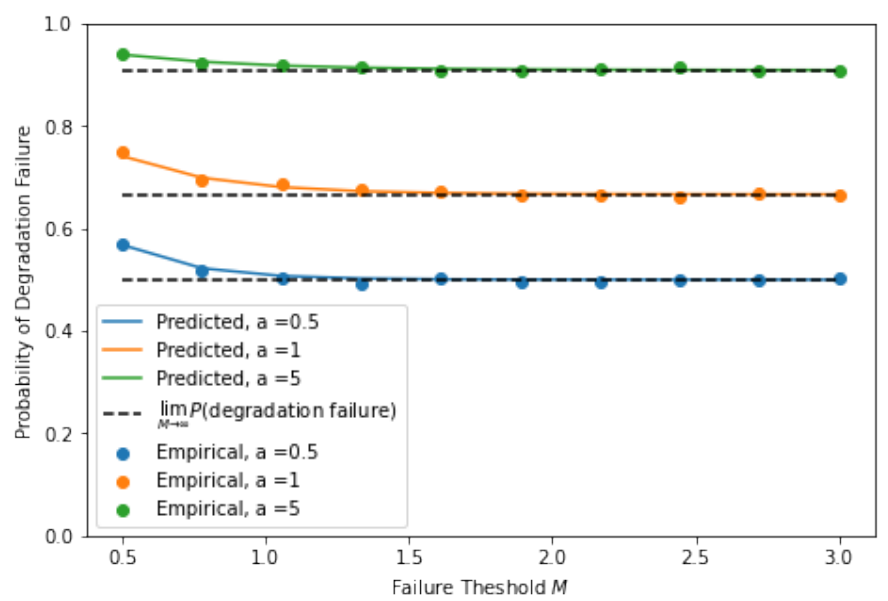
Figure 2. Predicted and empirical probabilities of degradation failures with limiting probabilities.